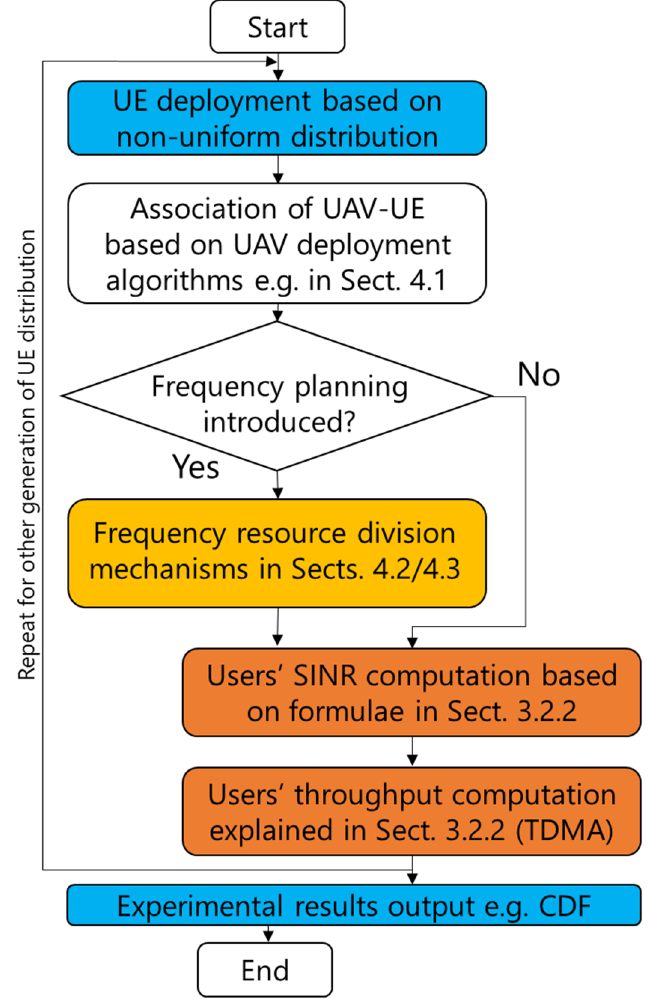
Figure A1. Computation process to derive numerical analysis results.